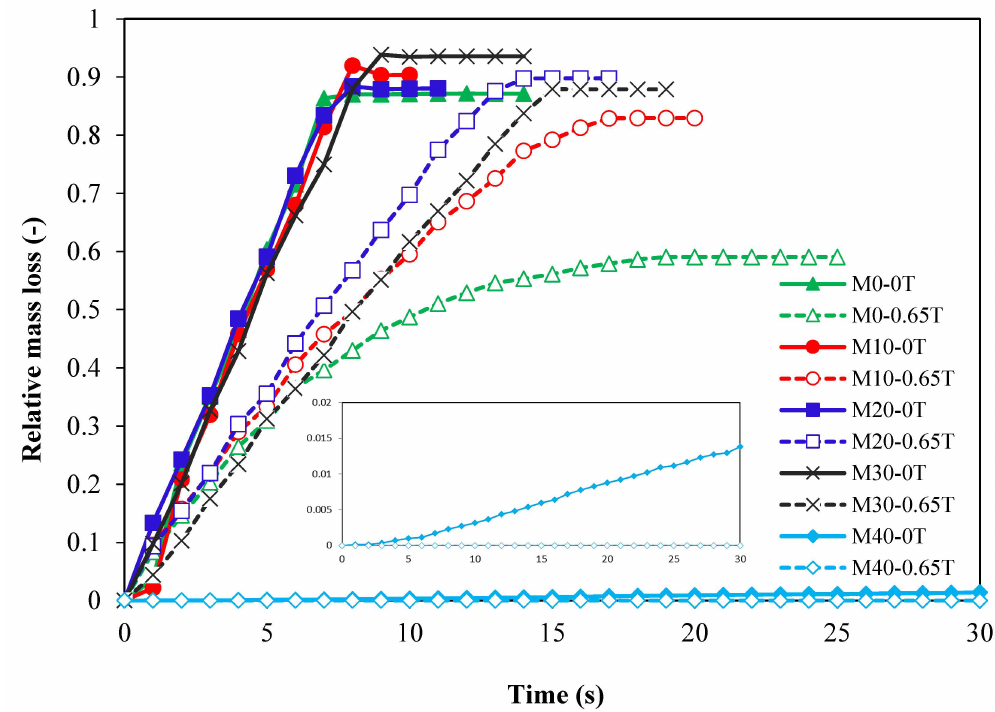
Figure 10. Relative mass loss as a function of time without ASC (solid lines) and with ASC (dashed